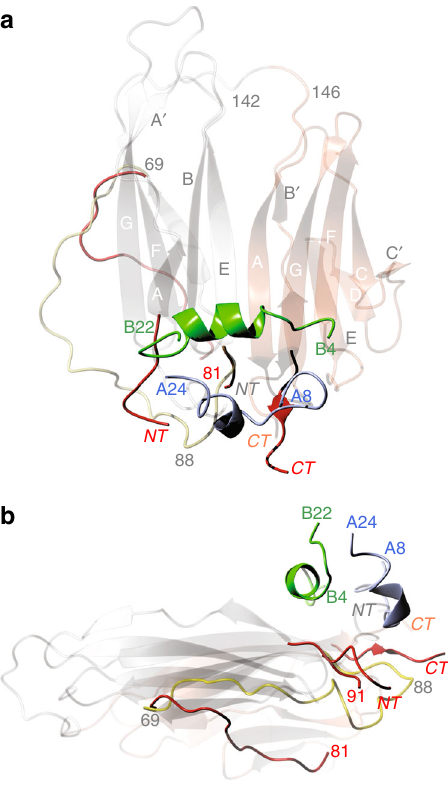
Fig. 4 Structure of the Imp-L2:DILP5 complex. a The top view, and b the side view (from the direction of the 70 – 92 loop of the apo-Imp-L2) of this complex. As the core of the apo-Imp-L2 remains practically invariant upon hormone binding the main differences between apo- and holo-Imp-L2: move of the 70 – 92 loop and split of the C-terminal and N-terminal, have been showed in red on the apo-Imp-L2 scaffold, with a general colour- coding as in Fig. 3. DILP5 B- and A-chains are in green and blue-grey, respectively